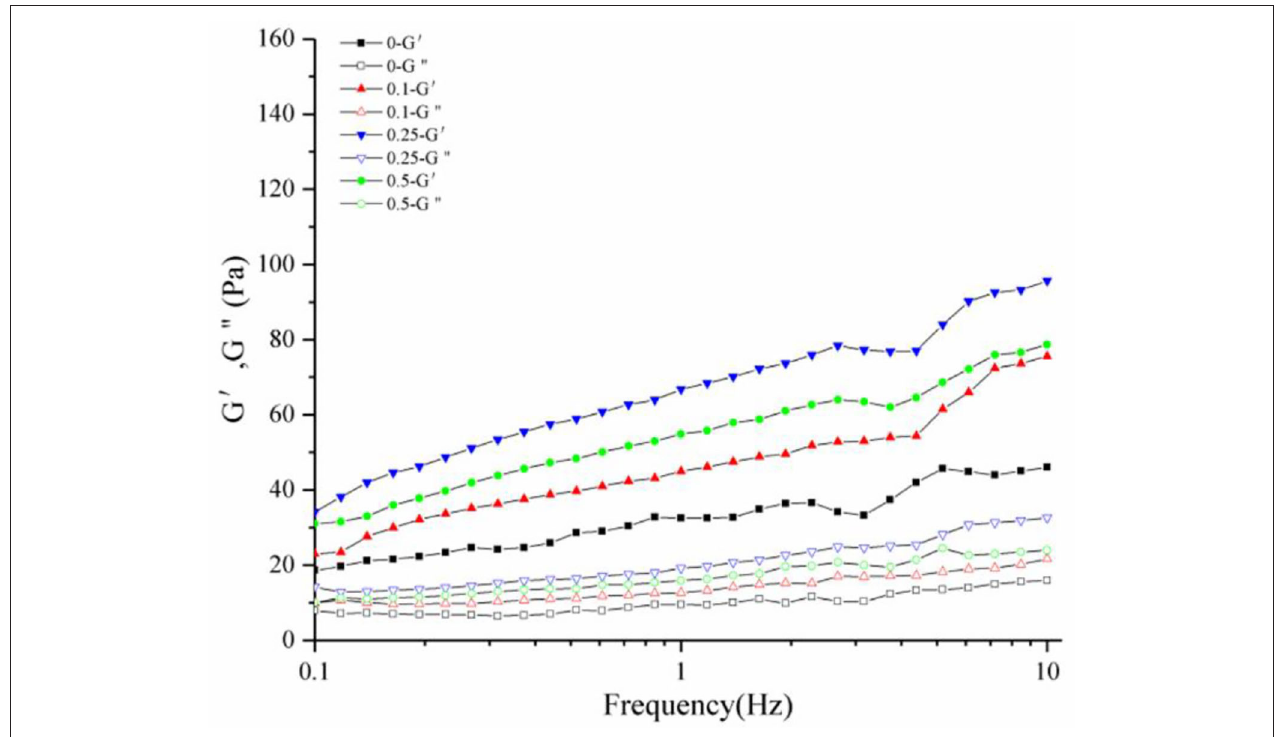
FIGURE 8 | Dynamic rheological diagram of yogurt. G’ is the elastic modulus, G" is the viscous modulus.